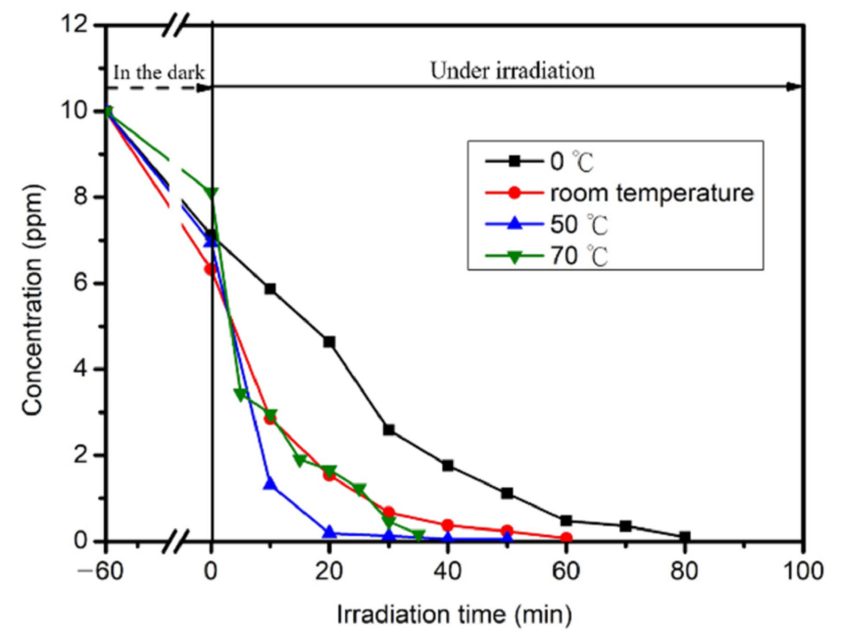
Figure 6. The change of the concentration of methylene blue on TiO 2 with time at different reac- tion temperatures.